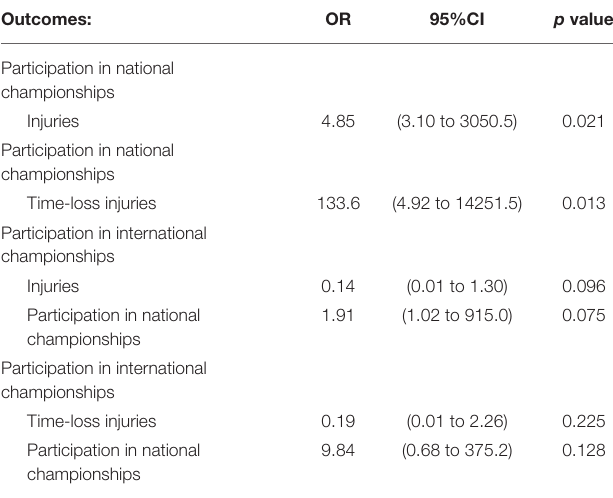
TABLE 2 | Odds ratio (OR) with 95% confidence interval (95% CI) of the association of injury occurrence [injuries or time-loss injuries (TLI) (yes/no)] with performance (1) participation in national championships (yes/no) or (2) participation in international championships (yes/no) adjusted for individual athlete and number of season (adjustment variables) and for participation in national championships for the participation in international championships, using a logistic regression.